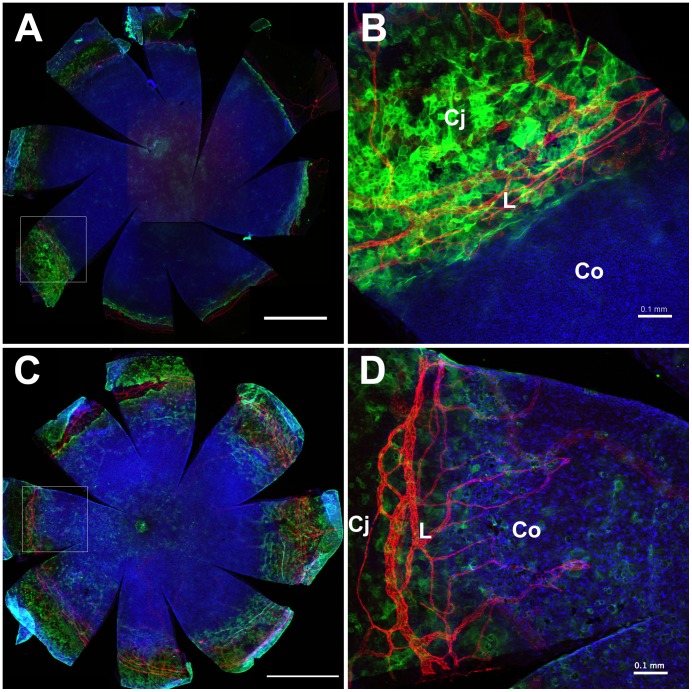
Identification of the corneo-limbal boundary in the WT and Pax6+/− mouse ocular surface epithelium.CD31 (red) and keratin 19 (green) double immunofluorescence staining in the ocular surface of (A, B) WT and (C, D) Pax6+/− mice. Images (B) and (D) are higher magnifications of the areas outlined in (A) and (C) respectively. Both CD31-positive blood vessels and keratin 19-positive epithelial cells are restricted to the conjunctiva and limbus in WT eyes but they both extend into the corneal epithelium in Pax6+/− mice. Abbreviations: L: Limbus; Co: Cornea; Cj: Conjunctiva. Red immunofluorescence: CD31; green: keratin 19; blue: TO-PRO3 iodide nuclear counterstain. Scale bars are 1 mm (A,C) and 0.1 mm (B,D).